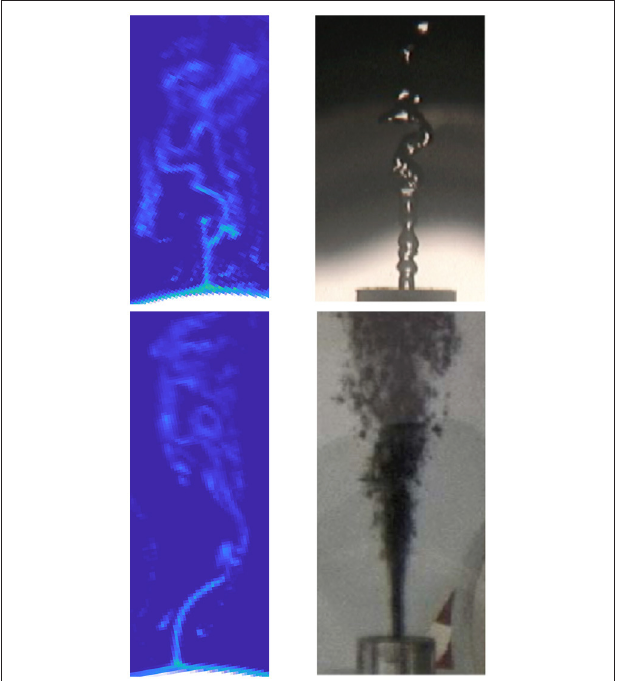
FIGURE 10 | (Left) Examples of chemical plumes for case 9 ∗ after the initial bottom light layer starts destabilizing at the beginning of the simulation. (Right) Examples of some regimes of jet instability in laboratory experiments. Taken from Tang et al. (2003).